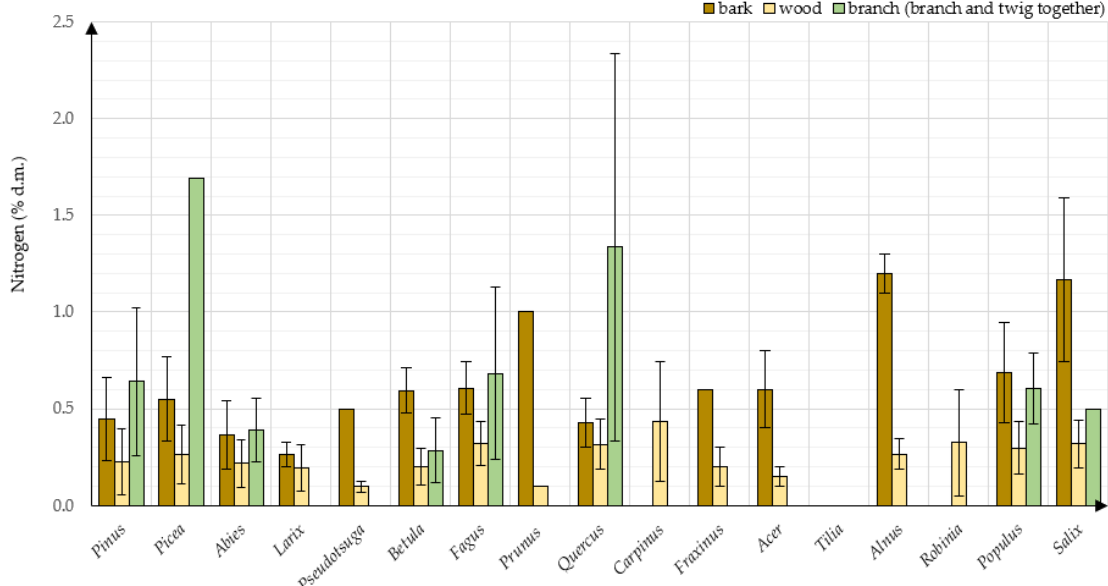
Figure 11. Average value and average deviation of the nitrogen content of organs of particular systematic genera